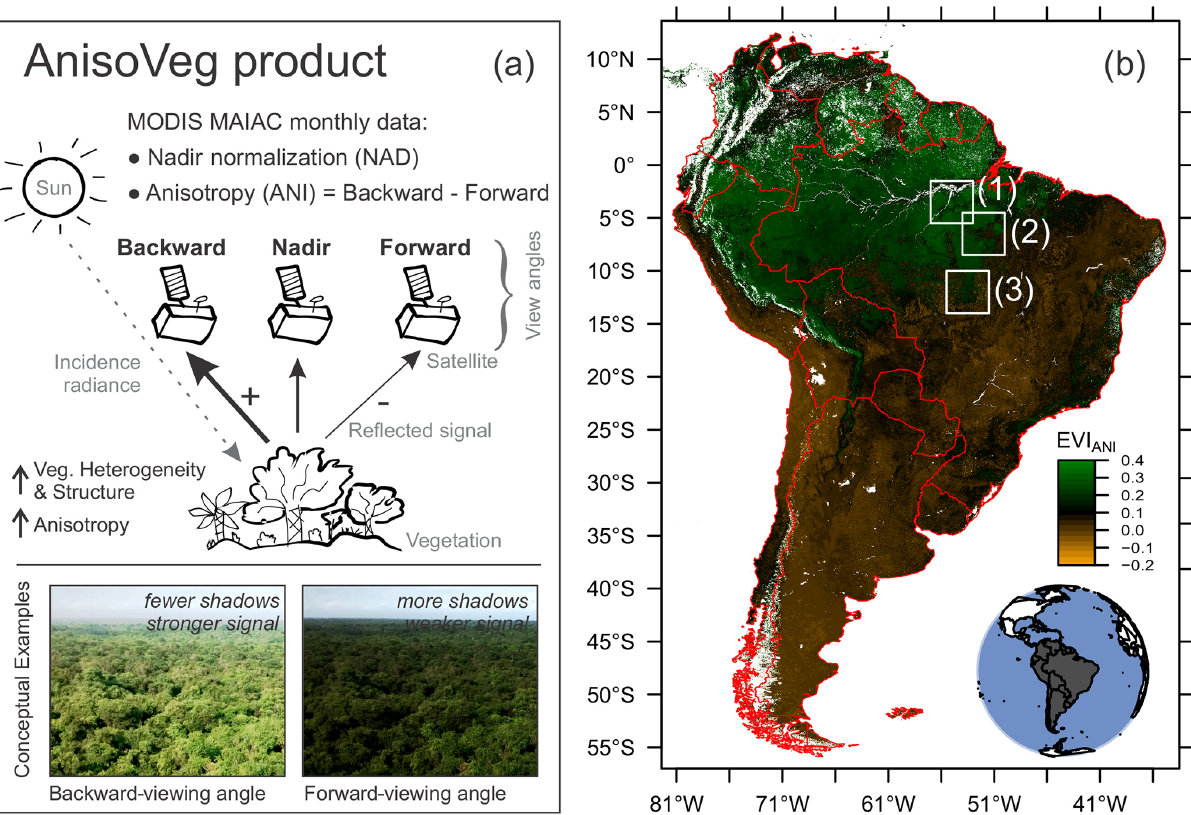
Figure 1. AnisoVeg product concept and the area of coverage. (a) Schematic representation showing the observational geometry and the processing steps for producing NAD and ANI data from MODIS and to provide information on vegetation heterogeneity and structure. (b) The visualization of the anisotropy EVI (EVI ANI ) for South America from August 2021 at 1km spatial resolution, showing the coverage of the product in South America and the location of three sites used to demonstrate potential applications. The sites are (1) Tapajós National Forest, (2) São Félix do Xingu, and (3) Xingu Indigenous Park. Red lines indicate the country